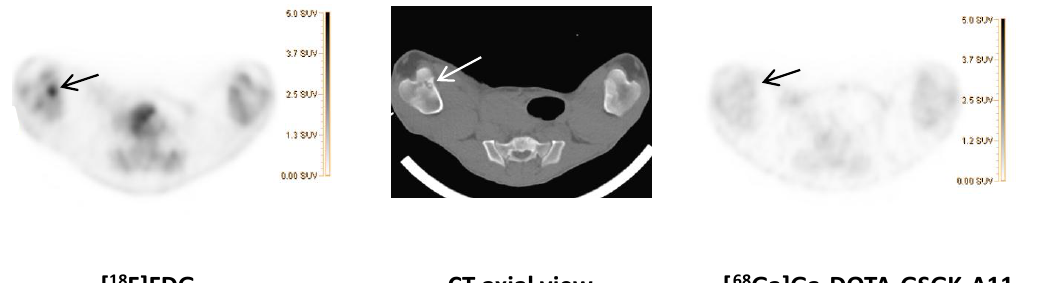
Figure 1. [ 68 Ga]Ga-DOTA-K-A9 compared to [ 18 F]FDG.